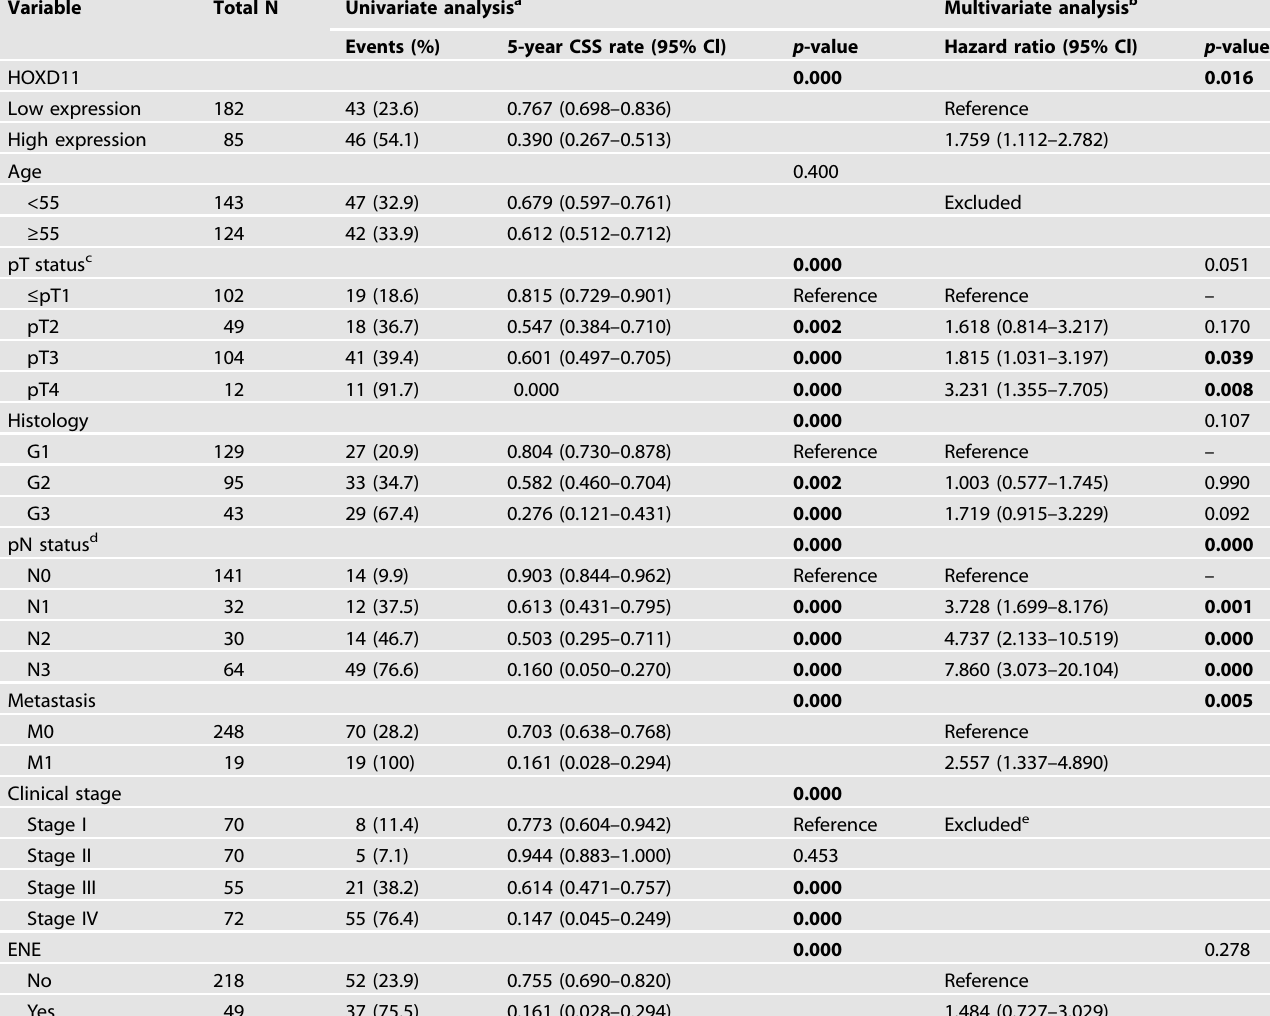
Table 2. Univariate and multivariate analyses of HOXD11 expression and clinicopathological features in 267 PSCC patients.